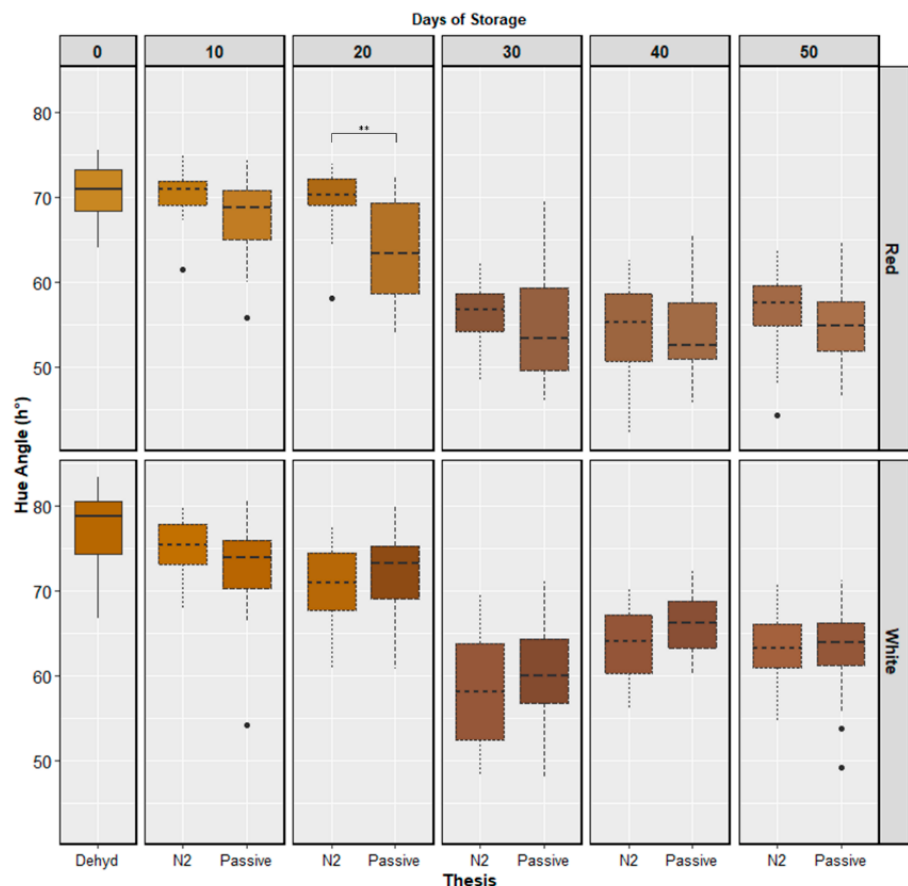
Figure 4. Hue angle ( h ◦ ) values of the dehydrated loquat samples analyzed over the course of the experiment. Box plots are filled with the median color value of the group, transformed from the CIE L * a * b * color space into printable hexadecimal values using the R package color-space. Asterisks between box plots indicate statistical significance of difference using Student’s T-statistic, with *— p < 0.05, **— p < 0.01, and ***— p < 0.001. No asterisk indicates a non-significant difference between the means of the treatments.